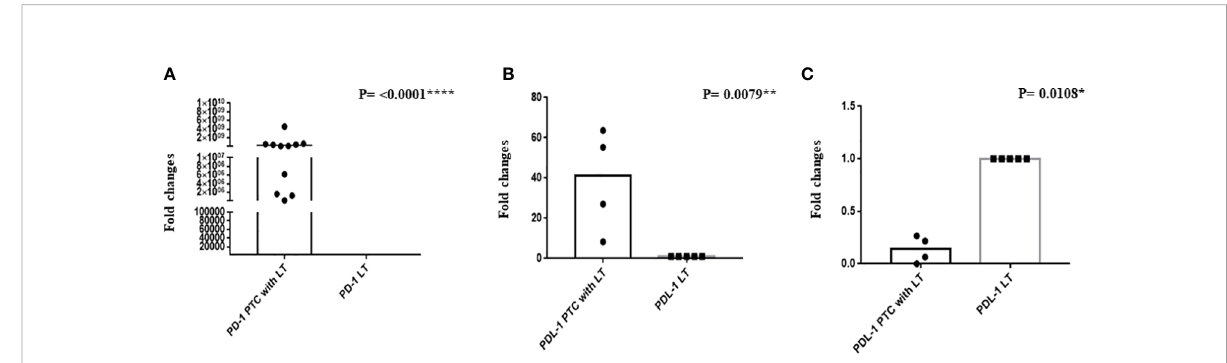
FIGURE 4 (A) Relative mRNA expression of PD-1 and (B, C) relative mRNA expression of